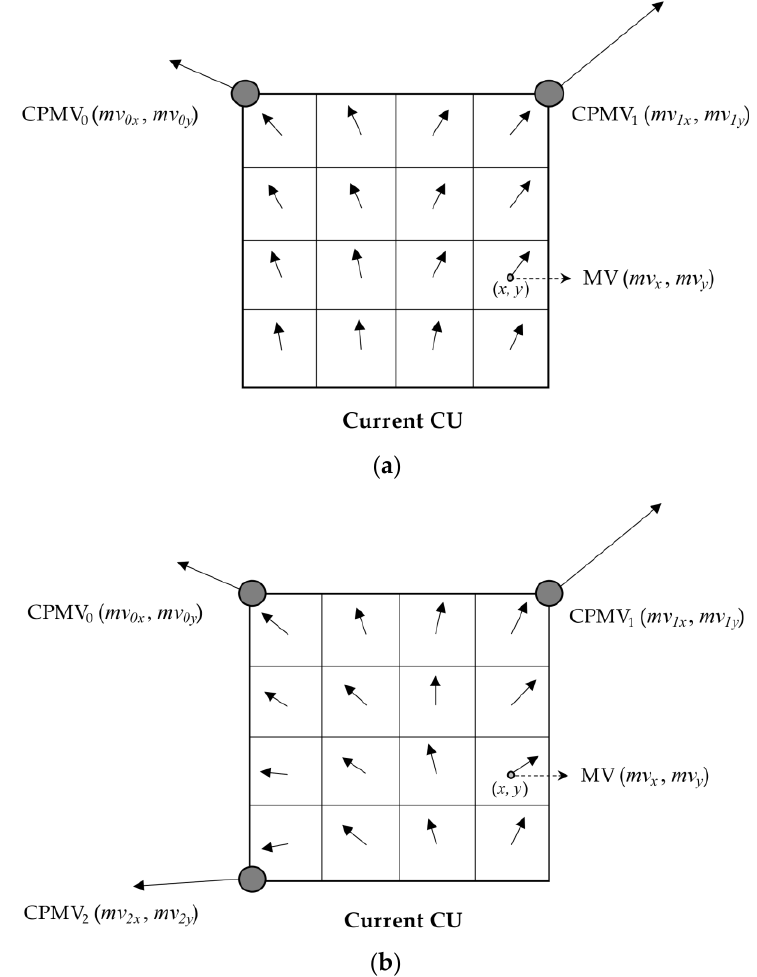
Figure 3. Affine MV derivation per a sub-block: ( a ) Affine MV derivation for four-parameter affine model; ( b ) Affine MV derivation for six-parameter affine model.